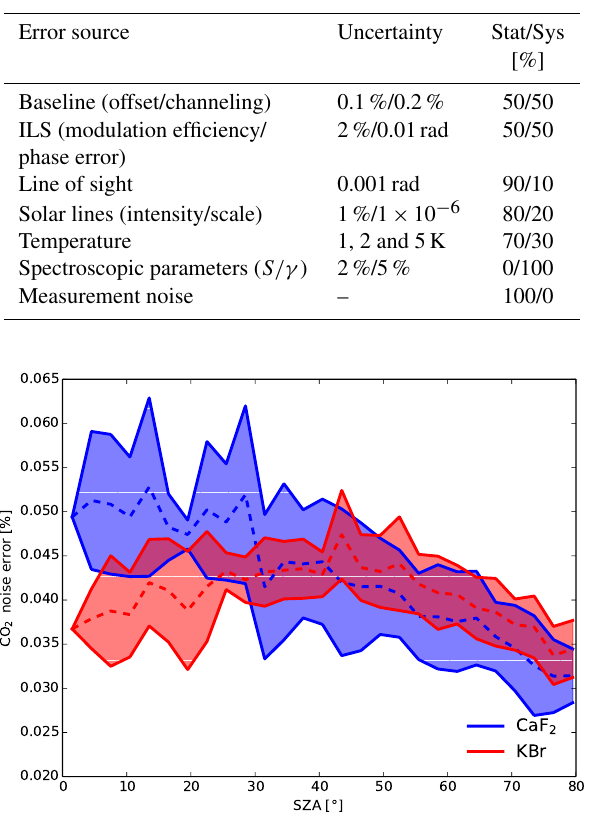
Figure 3. Mean noise error from PROFFIT for CO 2 total column as a function of SZA.